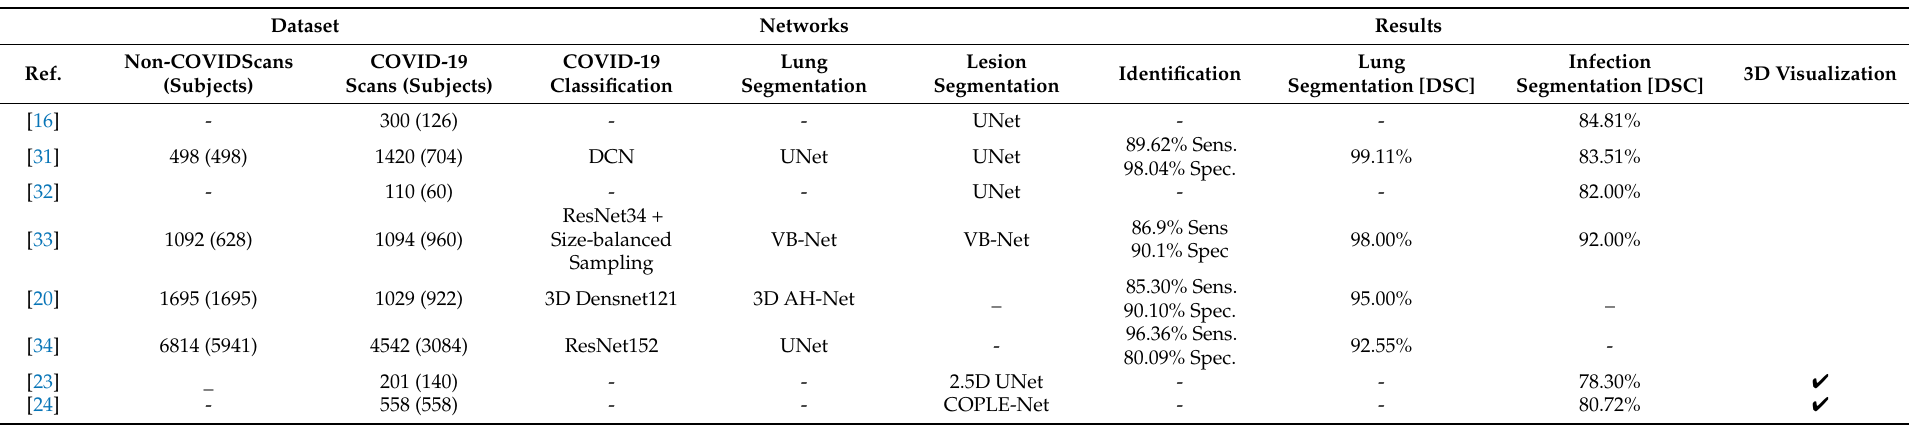
Table 1. A quantitative comparison between the state-of-the-art for classification and segmentation